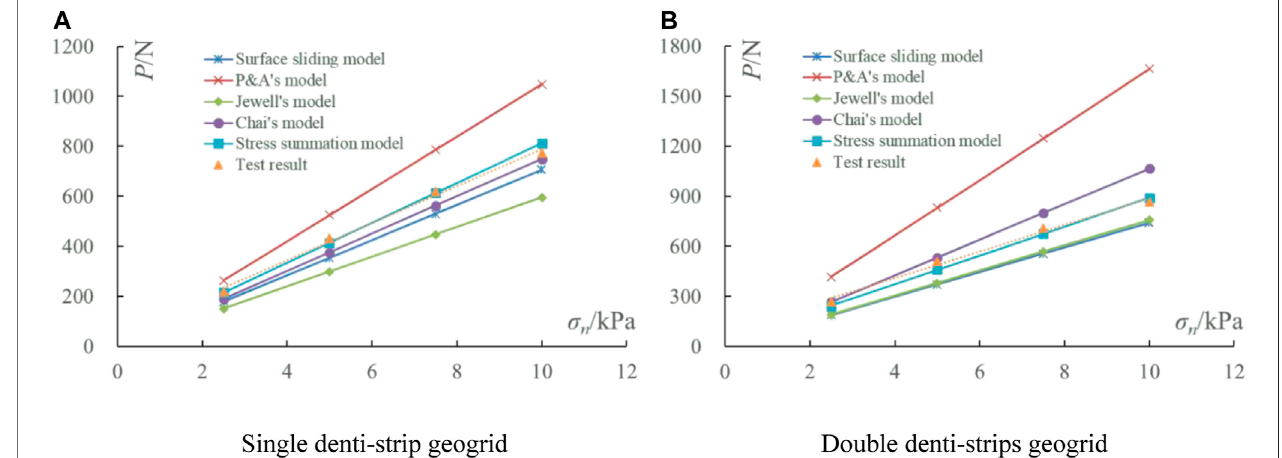
FIGURE 10 | Resistance comparison of different theoretical models. (A) Single denti-strip geogrid. (B) Double denti-strips geogrid.